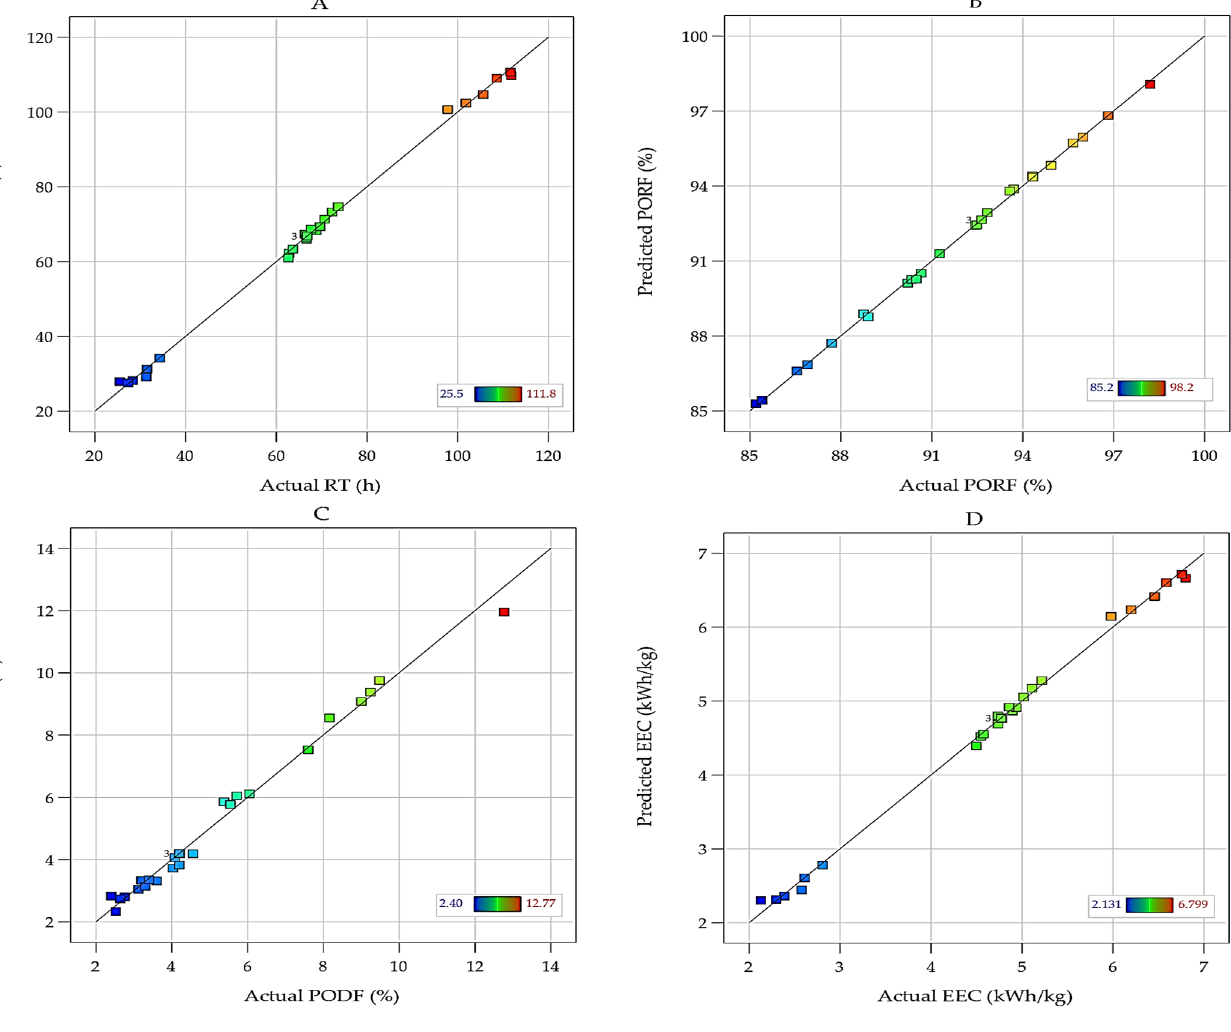
Figure 6. Scatter plots of the predicted values versus the actual values of the artificial ripening time ( A ), percentage of ripe fruits ( B ), percentage of damaged fruits ( C ), and electrical energy consumption ( D ).